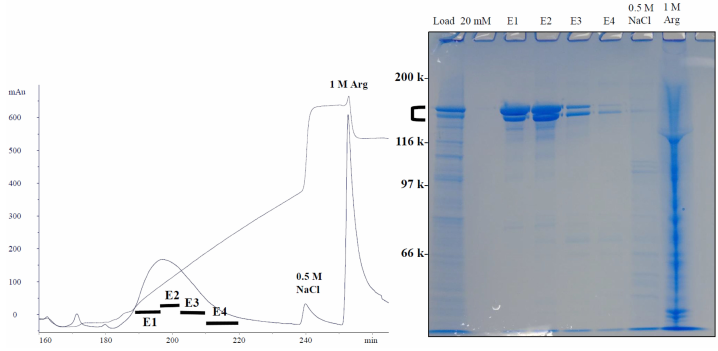
Figure 11. Purification of rabbit monoclonal antibody using Capto MMC mixed mode chromatography. Conditioned medium was adjusted to pH 6.0 and loaded onto Capto MMC at pH 5.2. After raising the column pH to 7.0, the bound proteins were eluted from 0 to 0.3 M NaCl. SDS-PAGE shows load, pH 7.0 wash (20 mM), eluted fractions of E1–E4 and final 0.5 M NaCl and 1 M arginine wash